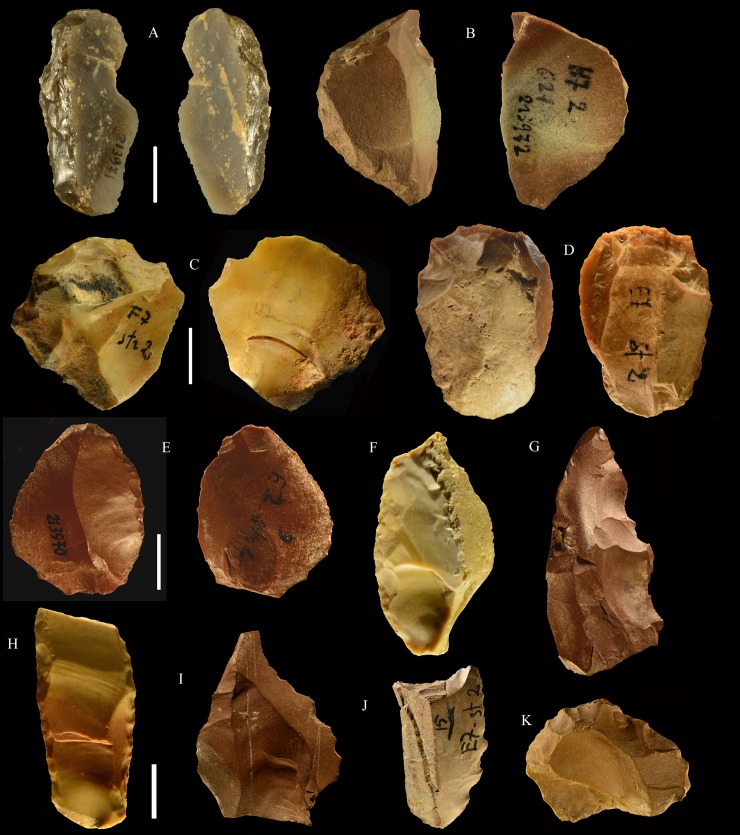
La Fabbrica.Uluzzian retouched pieces of flint (A,C, F, H) and jasper (B, D, E, G, I-K). (A) backed piece (lunate) on a laminar flake, the platform was removed. The backing retouch is both direct and inverse. The notch on the right side is not intentional, it is a natural fracture due to fissuring in the flint. (B) backed piece (lunate) on a flake with little retouch on the distal point, the platform was removed. (C) end scraper on flake with traces of organic residue on one side and thermal scar. (D) end scraper on a bipolar core. (E) endscraper on unidirectional flake. (F) side scraper on a unidirectional flake with a cortical side. (G) denticulate on the ventral face of a flake. (H) double scraper on a blade. (I) denticulate on a flake with convergent dorsal scars from a non-Levallois core. (J) Concave truncation and partial denticulate on the right side of a blade. (K) endscraper on flake. Catalogue numbers: 3, 5, 6, 32, 8, 14, 82, 80, 19, 18, 10. Scale bar = 1 cm.